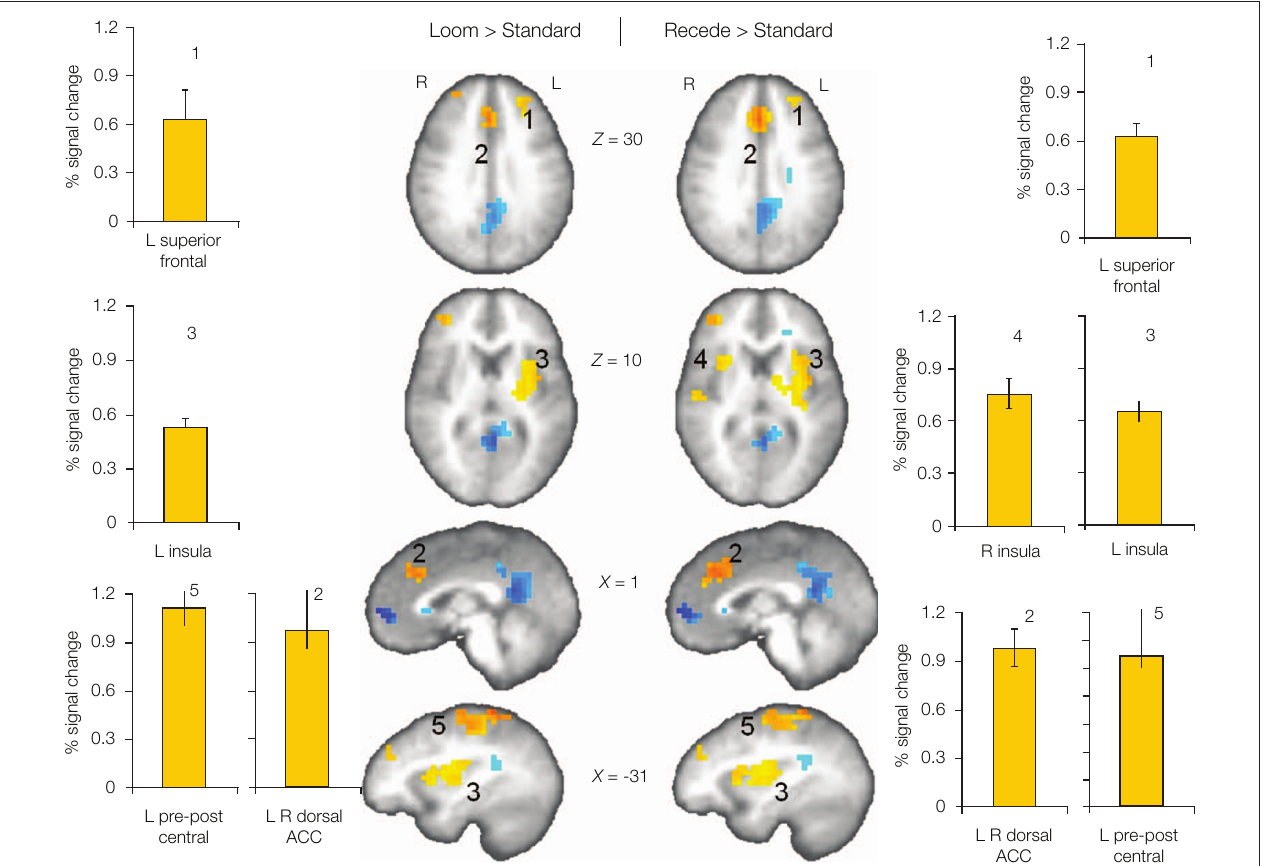
(row 3 and 4); percent signal change is plotted (mean; SEM) as obtained through t -tests ( P < 0.001, corrected). Numbers in slices correspond to numbers in bar charts representing the average percent signal change in specific regions of interest.